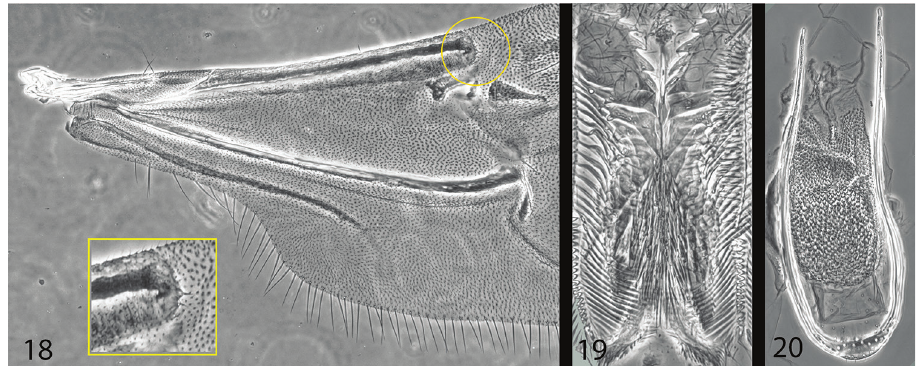
Elytra with striae impressed, punctures deep, subconfluent; interstriae about as broad as striae, with very fine irregularly spaced punctures; postero-lateral (interstrial) rim slightly elevated with 2–3 blunt granules. Vestiture consisting of scattered erect, golden setae on discal interstriae, somewhat shorter on declivity. Legs. Protibiae with three lateral teeth (embedded denticles), and one additional tooth just above the inner mucro; posterior face smooth. Ventral vestiture simple, on ventrites consisting of a few irregularly placed short setae close to the lateral margins. Distribution and biology. Known from Ghana, Cameroon and Congo. New re- cord: Cameroon, Mt. Cameroon south slope, 1600 m, GIS: [4.12, 9.16], Ficus branch, B. Jordal 28xi-8 [28. Nov. 2007] (ZMBN/ENT_Scol4931, 4941). It was taken to- gether with M. angustus under thick bark of large fallen Ficus tree (see above).